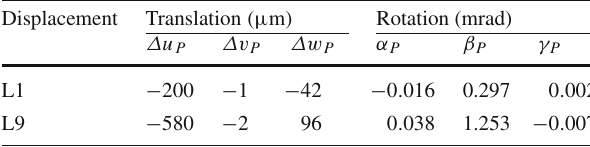
Table 3 The displacements of L1 and L9 introduced by 180 ◦ detector rotation obtained from the test-beam